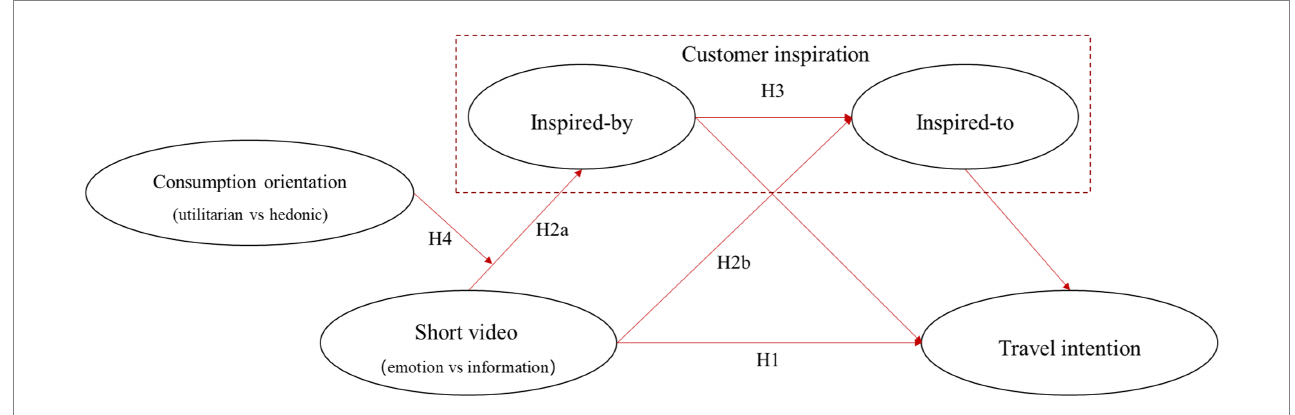
FIGURE 1 Research